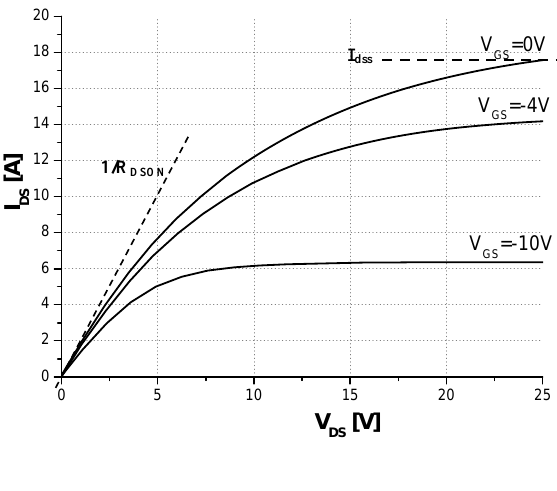
Figure 6. Experimental drain-current versus drain voltage characteristics as a Vgs parameter at room temperature of the 15 A-1,200 V SiC-JFET sample.